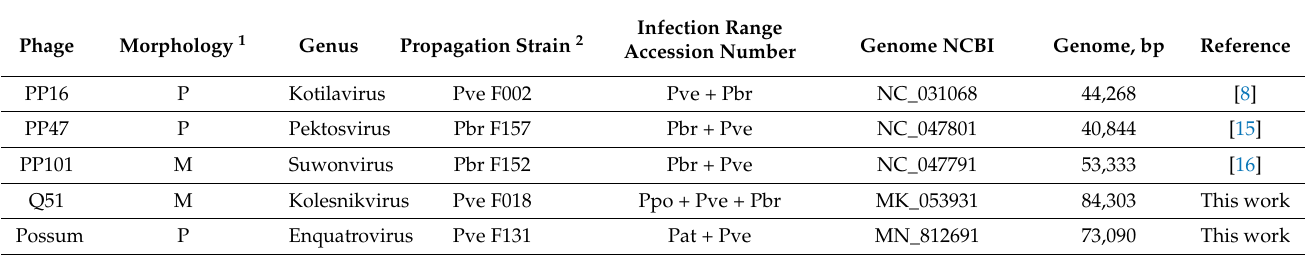
Table 2. Properties of bacteriophages comprising the experimental phage